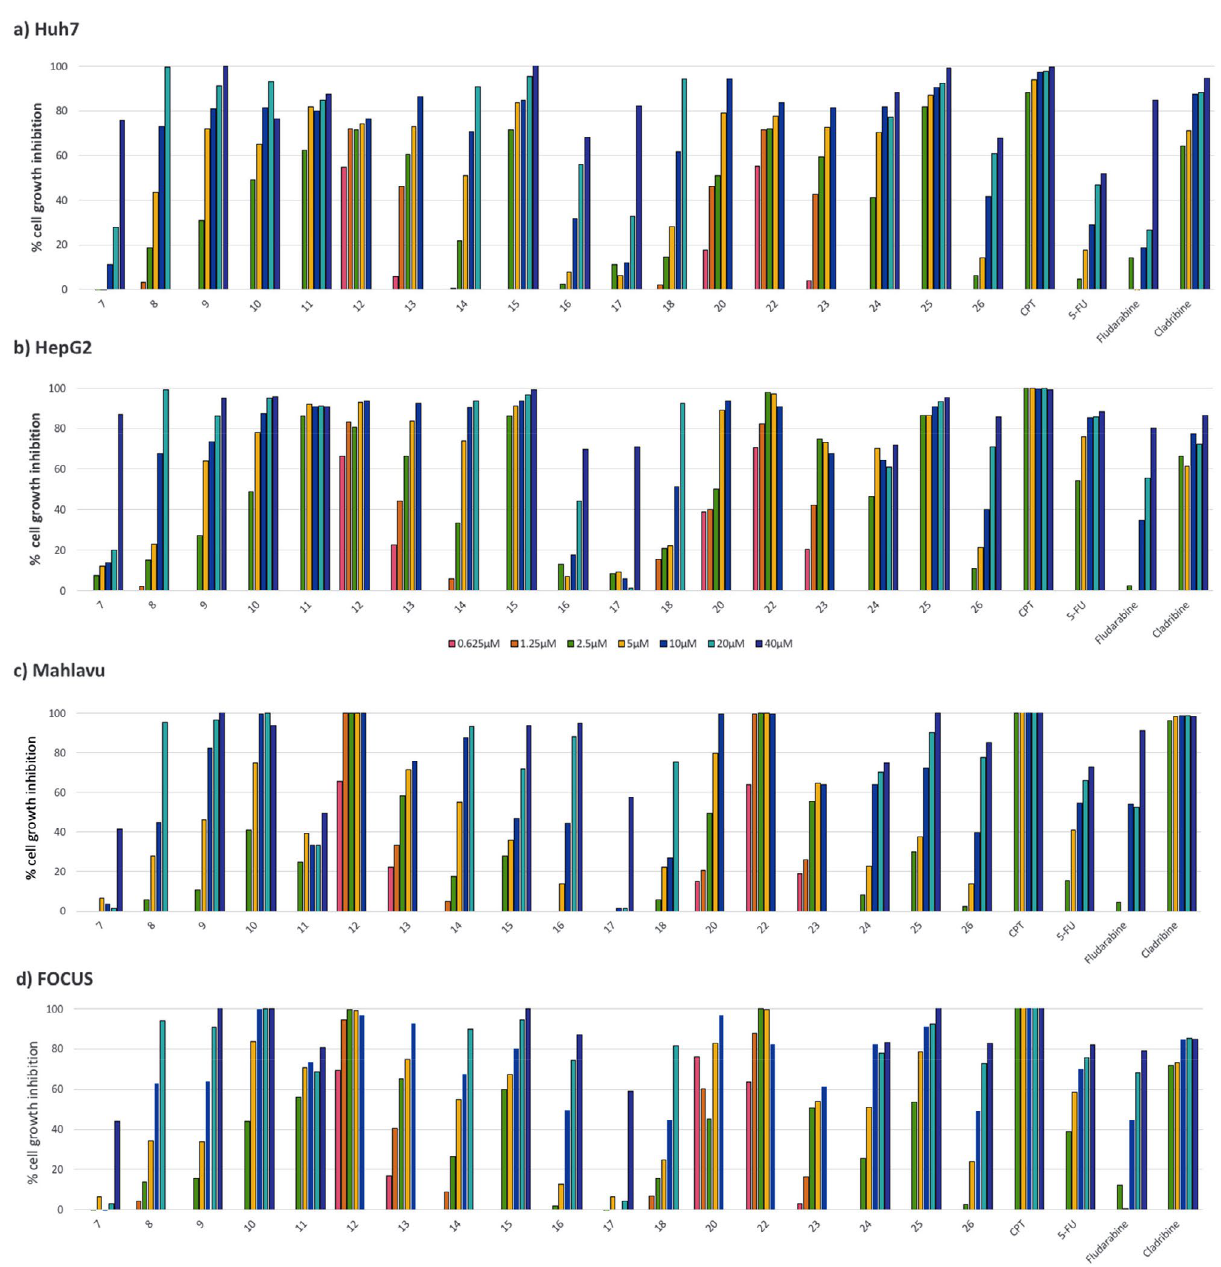
Figure 3. Percent cell death in the presence of most active compounds. Huh7, HepG2, Mahlavu and FOCUS cells were inoculated in 96-well plates. All molecules and their DMSO controls were administered to the cells in triplicate with five different concentrations: 40, 20, 10, 5, and 2.5 μM. After 72 h of incubation, SRB assays were generated, and the cell death percentages were calculated in comparison with DMSO-treated